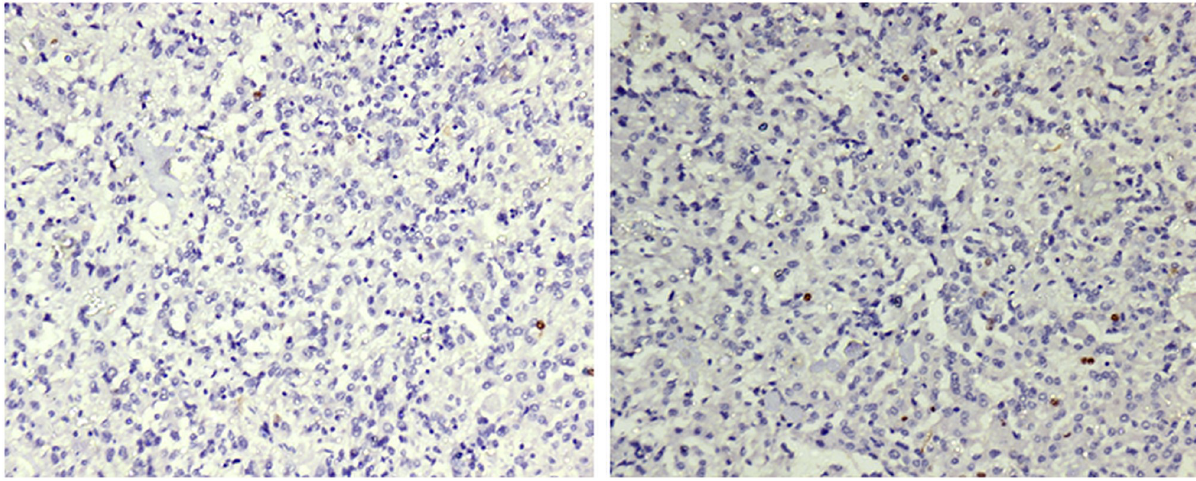
Fig 2. These figures show the expression of Ki-67 in two different grades of meningioma (a) expression of Ki-67 in meningioma grade-I; (b) Expression of Ki-67 in meningioma grade-II.